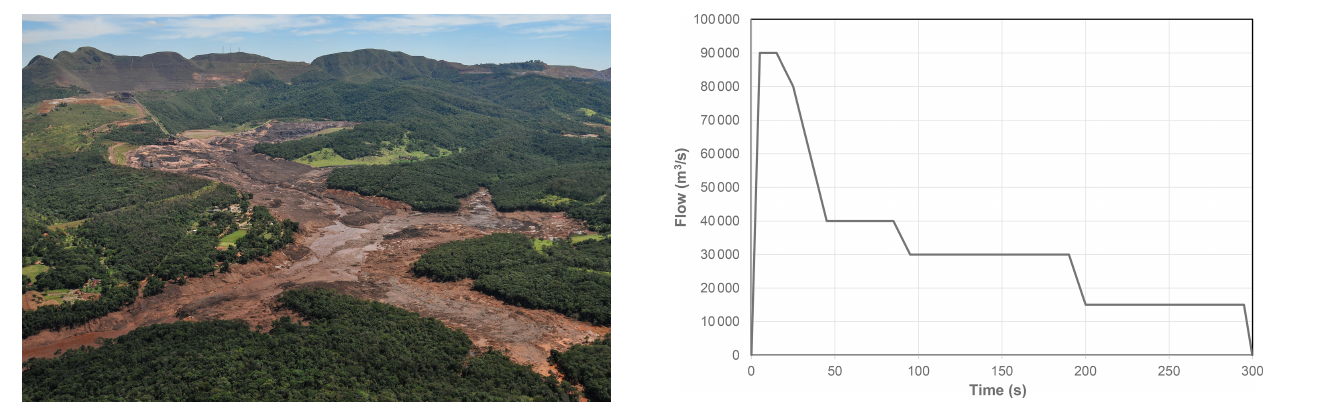
Figure 5. Photograph taken on 1 February 2019 showing the af- termath of the Brumadinho dam failure directly downstream of the site (source: Felipe Werneck, Instituto Brasileiro do Meio Ambiente e dos Recursos Naturais Renováveis; reproduced under a Wikime- dia Commons CC-BY-SA-2.0 licence).